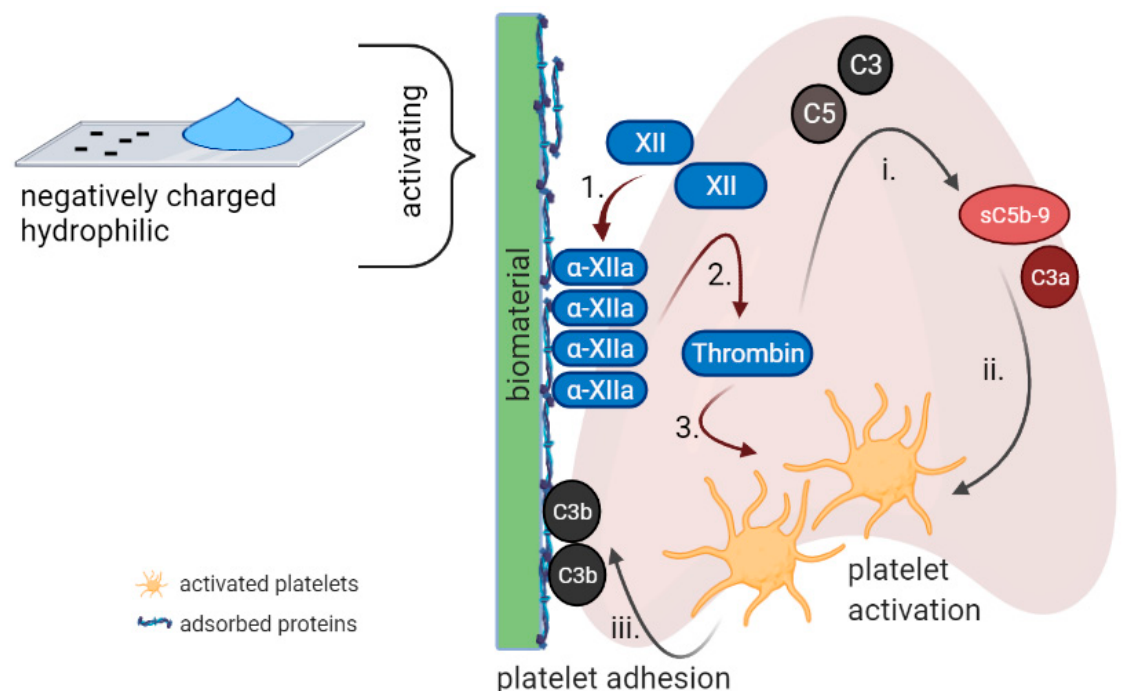
Figure 2. Surface-mediated complement-coagulation interplay. Factor XII of the contact system preferentially binds to negatively charged/hydrophilic surfaces generating Factor α -XIIa, which is also adsorbed onto biomaterial surfaces (1.) and further activates the contact system pathway of the coagulation cascade, generating thrombin (2.) that can, in turn, intensively activate platelets (3.). Thrombin cleaves C3 and C5 to C3a/C3b and C5a/sC5b-9, respectively, thus amplifying the activation of complement (i.) C3a activates platelets, enhancing their aggregation and adhesion. sC5b-9 is incorporated into the cellular membrane of platelets, inducing an alteration in membrane polarization and, thus, increasing the surface area on which clotting can occur (ii.). C3b binds to P-selectin and enhances platelet adhesion (iii.). Created with BioRender.com.